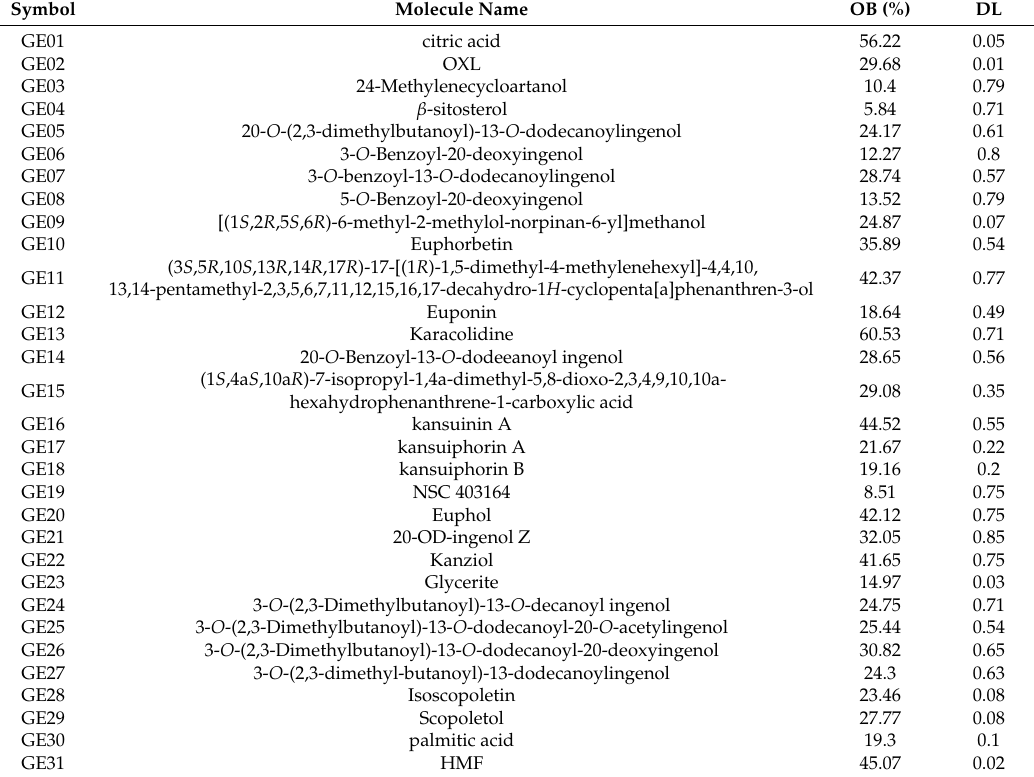
Table 2. Chemical information of compounds in